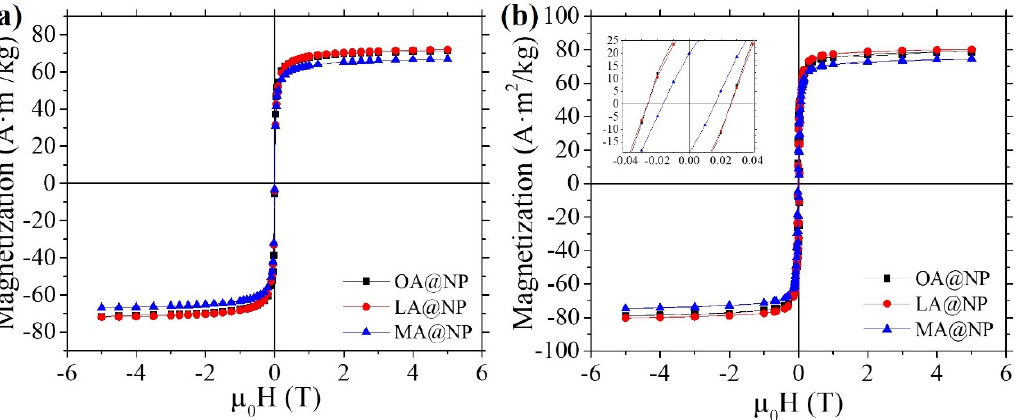
Figure 3. Magnetization curves at ( a ) 250 K and ( b ) 5 K for the three samples OA @NP, LA @NP, and MA@NP. The reduced remanence ( M S / M R ) at 5 K (see Table 2) is far from the theoretical value of 0.5 for non-interacting uniaxial single-domain particles, confirming the presence of non-negligible interparticle interactions, especially for MA@NP. Table 2. Saturation magnetization at 250 K ( M S 250K ), saturation magnetization at 5 K ( M S 5K ),